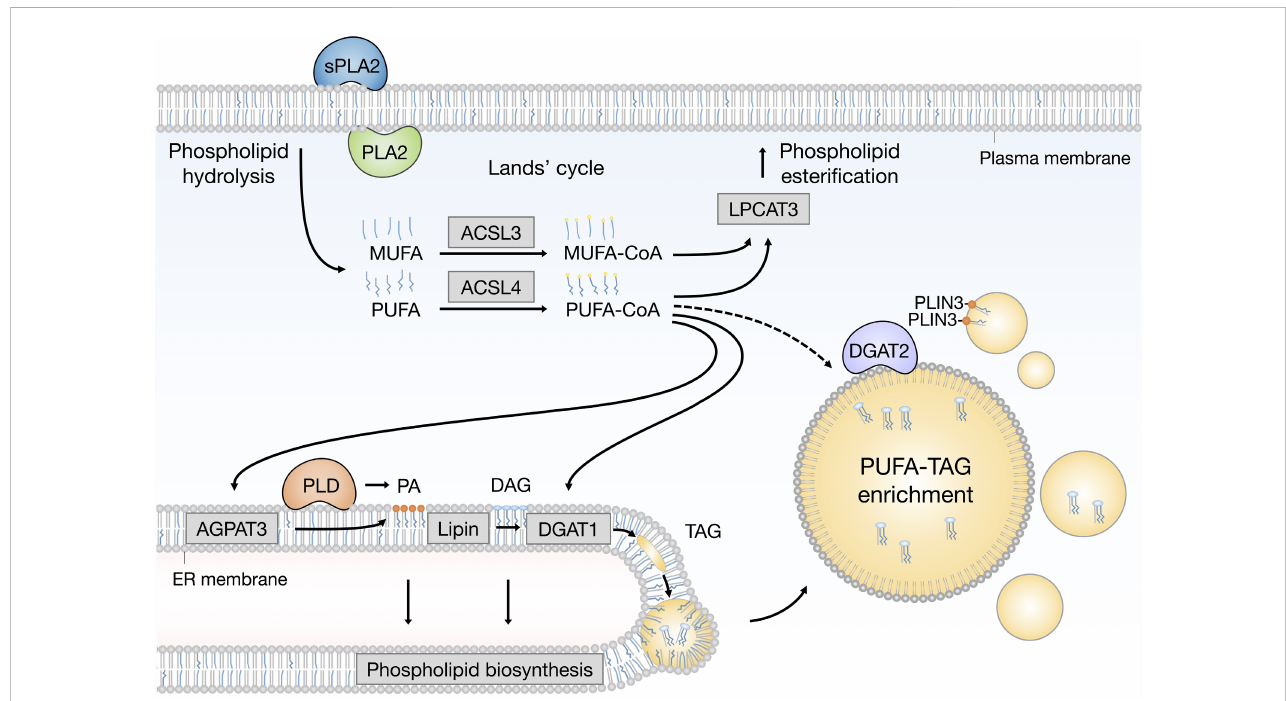
FIGURE 2 EmergingpathwaysofPUFAchannelingfrommembranestolipiddroplets(LDs).TheredistributionofPUFAsintoTAGsstoredwithinLDscanoccur via at least two conceptually distinct lipid remodeling pathways driven by PLA 2 and PLD enzymes. PLA 2 -catalysed phospholipid hydrolysis liberates membrane resident PUFAs, which are released into the cytosol. To re-enter any metabolic or remodeling pathways, including the Kennedy pathway of de novo phospholipid and TAG biosynthesis, PUFAs have to be fi rst converted into active PUFA-CoA intermediates by CoA synthetase enzymes, such as ACSL4, which shows preference for PUFAs, whereas the activation of MUFAs is preferentially handled by ACSL3. On the other hand, PLD-catalyzed hydrolysis of PUFA-rich phospholipids generates PUFA-containing PA, which remains con fi ned to the 2D space of the membrane bilayer. This in principle enables a more ef fi cient channeling ofthePUFA acylchainintoTAGs via theKennedypathwaybythesequentialactionoflipinandDGAT1enzymeswithin theERmembrane. PUFA-PA can also be formed de novo via the AGPAT3 enzyme with known preference for PUFAs. In principle, with the help of LD-associated ACSL4, free PUFAs can also be converted into PUFA-TAGs by the DGAT2 enzyme, which can relocate from the ER to LDs to catalyze local LD expansion. In addition, PA formed by PLD can participate in lipid droplet formation and expansion by PLIN3 recruitment. Cofactors and by-products are omitted. ACSL3: acyl-CoA synthetase long chain family member 3; ACSL4: acyl-CoA synthetase long chain family member 4; AGPAT3 (also known as LPAAT3): 1-acyl- sn -glycerol-3- phosphate acyltransferase gamma; CoA: coenzyme A; DAG: diacylglycerol; DGAT1: diacylglycerol acyltransferase 1; ER: endoplasmic reticulum; LPCAT3: lysophosphatidylcholine acyltransferase 3; MUFA: monounsaturated fatty acid; PA: phosphatidic acid; PC: phosphatidylcholine;